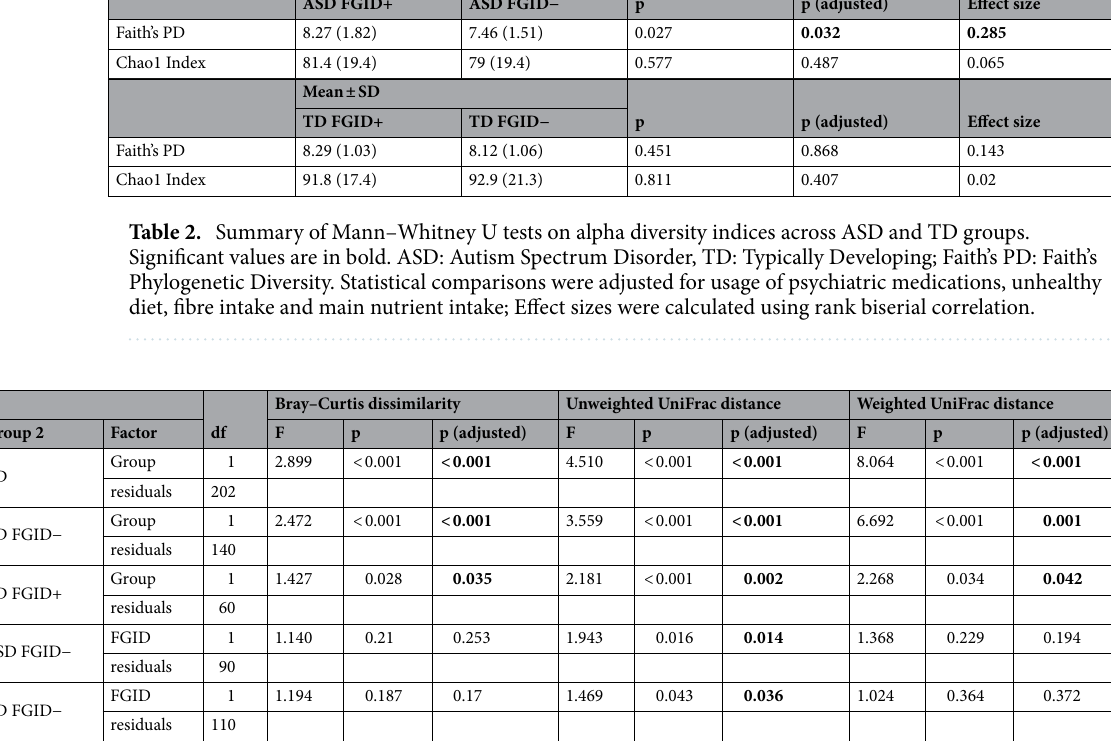
Table 3. Summary of PERMANOVA on beta diversity indices across ASD and TD groups. Significant values are in bold. ASD Autism Spectrum Disorder, TD Typically Developing, FGID Functional Gastrointestinal Disorder. Permutations = 1000 with statistical adjustment for usage of psychiatric medications, unhealthy diet, fibre intake and main nutrient intake.